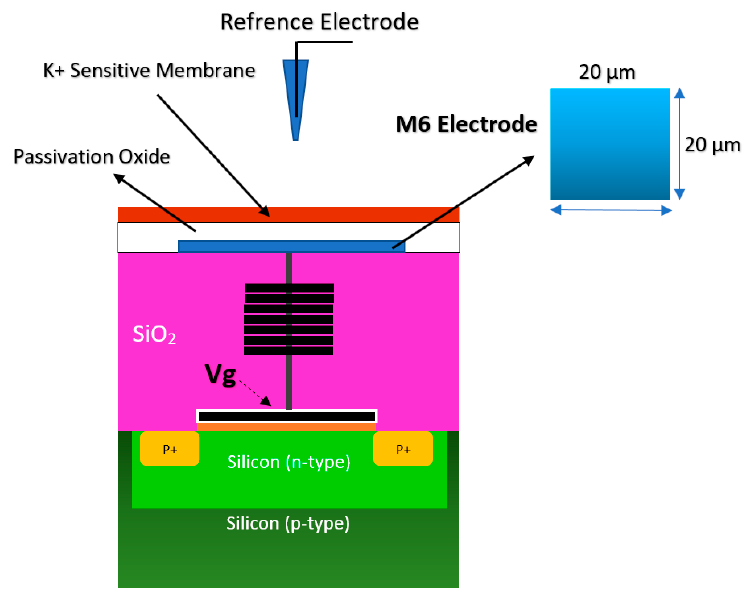
Figure 6. The standard complementary metal-oxide-semiconductor (CMOS) ISFET for rapid detection of E. coli bacteria using an unchanged CMOS structure coated with potassium sensitive membrane.